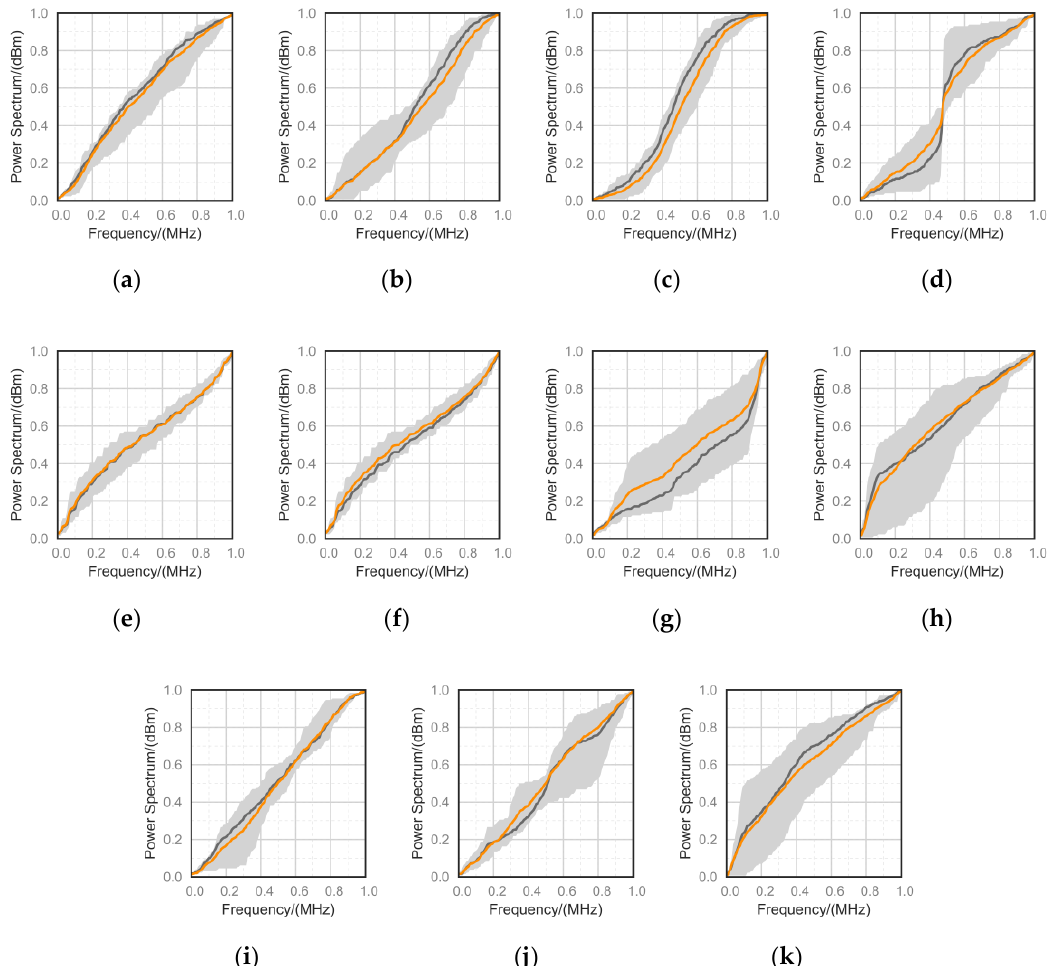
Figure 11. Empirical CDF computed on various fake modulation signals: ( a ) 8PSK; ( b ) AM-DSB; ( c ) AM-SSB; ( d ) BPSK; ( e ) QPSK; ( f ) CPFSK; ( g ) GFSK; ( h ) PAW4; ( i ) 16-QAM; ( j ) 64-QAM; ( k ) WBFM.